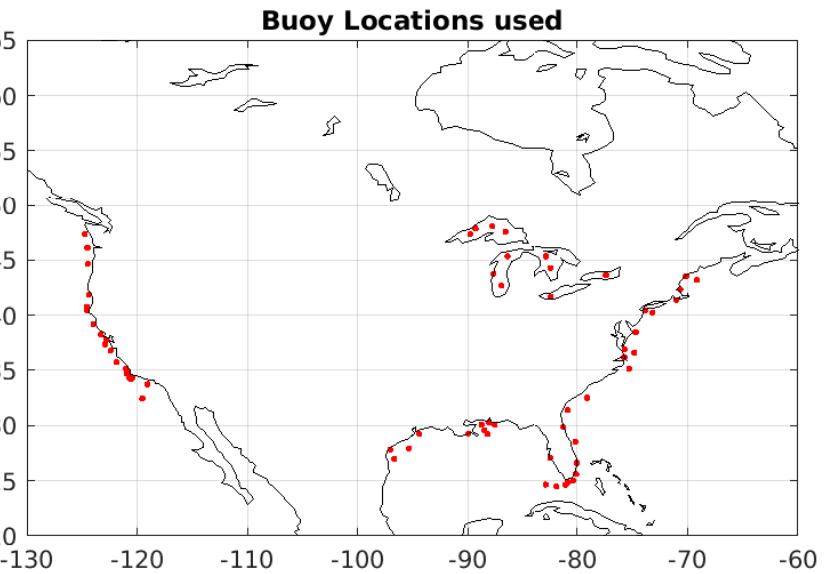
Figure 1. Locations of NDBC buoys used in this data analysis, we use all NDBC buoys that were within 100 km of coastline, including some in the Great